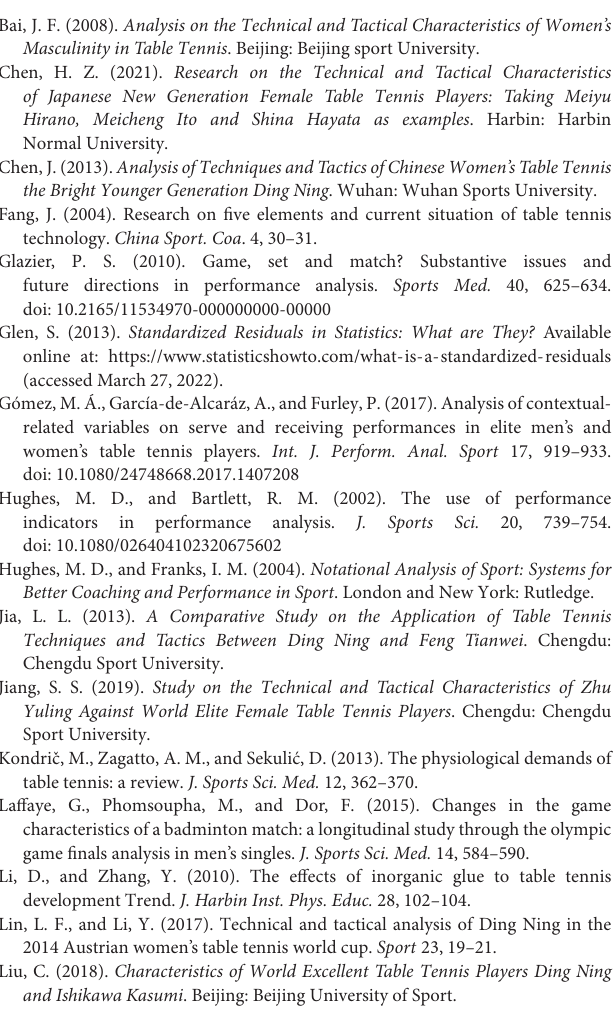
table tennis: a review. J. Sports Sci. Med. 12, 362–370. Laffaye, G., Phomsoupha, M., and Dor, F. (2015). Changes in the game characteristics ofabadminton match: alongitudinal studythroughtheolympic game finals analysis in men’s singles. J. Sports Sci. Med. 14, 584 – 590. Li, D., and Zhang, Y. (2010). The effects of inorganic glue to table tennis development Trend. J. Harbin Inst. Phys. Educ. 28, 102 – 104. Lin, L. F., and Li, Y. (2017). Technical and tactical analysis of Ding Ning in the 2014 Austrian women’s table tennis world cup. Sport 23, 19 – 21. Liu, C. (2018). Characteristics of World Excellent Table Tennis Players Ding Ning and Ishikawa Kasumi . Beijing: Beijing University of Sport.